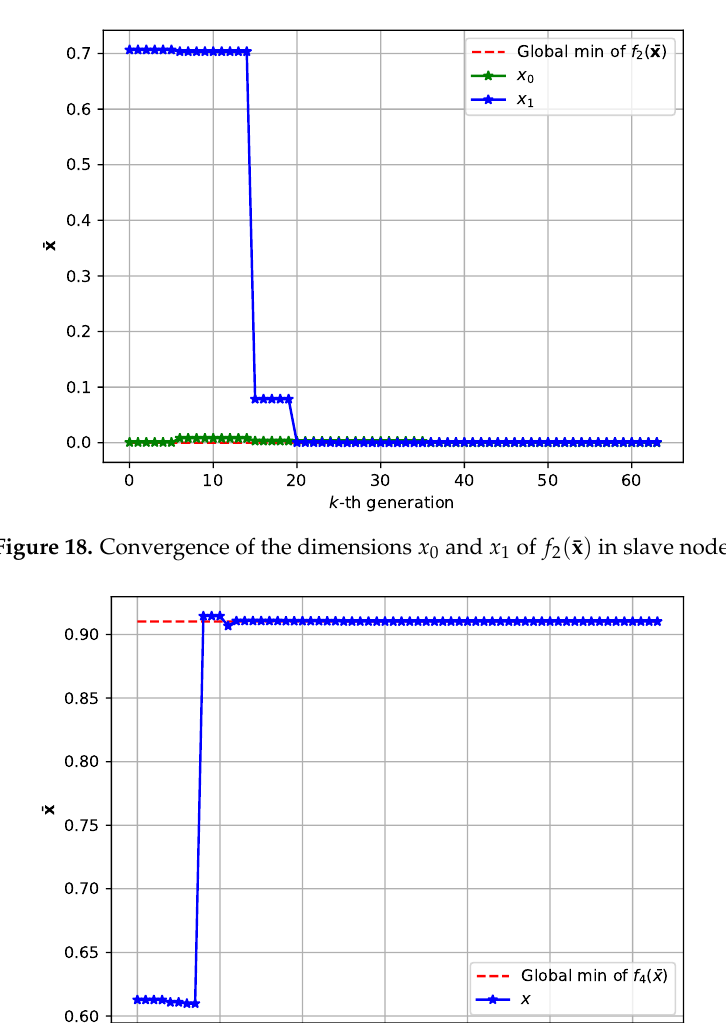
Figure 17. Convergence of the dimensions x 0 and x 1 of f 2 ( ¯x ) in master node.